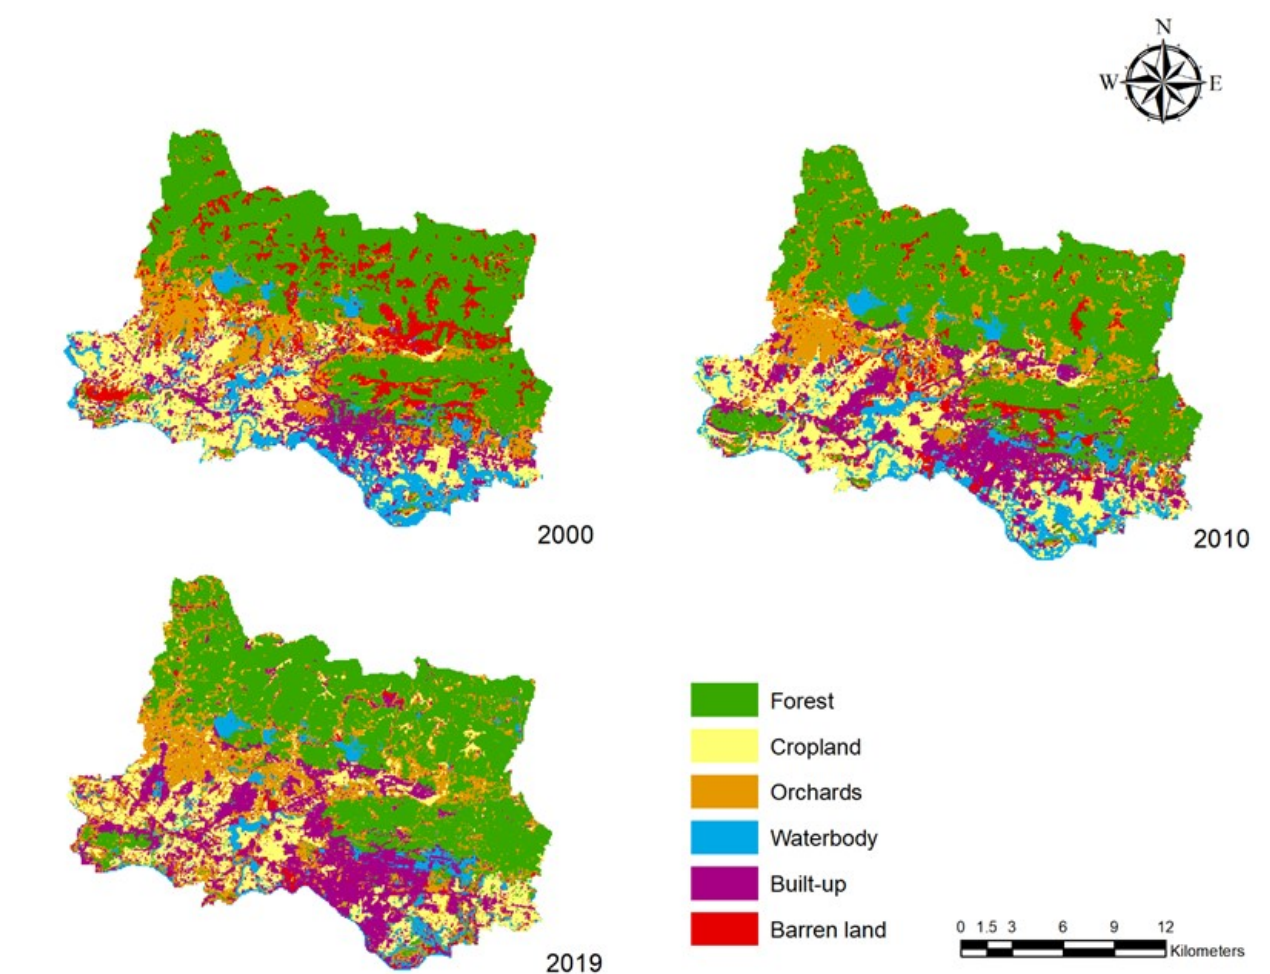
Figure 3. Land-use/land-cover map of Dong Trieu district from 2000 to 2019.